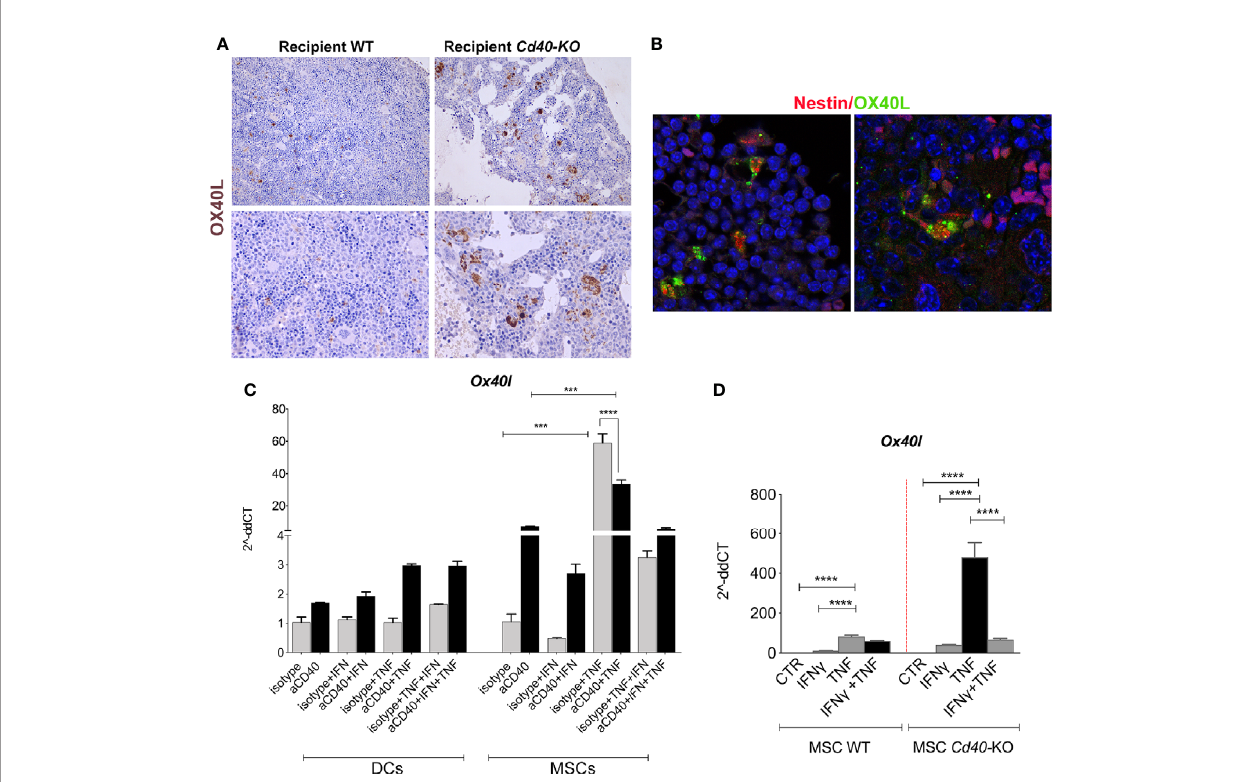
FIGURE 5 | OX40L release is negatively regulated by CD40 triggering. (A) Representative images of OX40L staining in BM sections of the WT>WT and WT> Cd40- KO BM chimeras. (B) IF revealed the co-localization between nestin (BM-MSC marker, red) and OX40L (green). (C) ox40l expression in Dendritic cells (DCs) and BM- MSCs stimulated with IFN- g 10 ng/ml, TNF- a 50 ng/ml, and aCD40 mAb or with isotype control (5 m g/ml) for 24 h (n = 3/group, one-way ANOVA, Tukey ’ s mupltiple comparison). (D) Quantitative RT-PCR analysis for Ox40l in WT and Cd40- KO BM-MSCs treated in vitro with IFN- g , TNF- a , or their combination (***p < 0.001, ****p < 0.0001, ANOVA, Tukey ’ s multiple